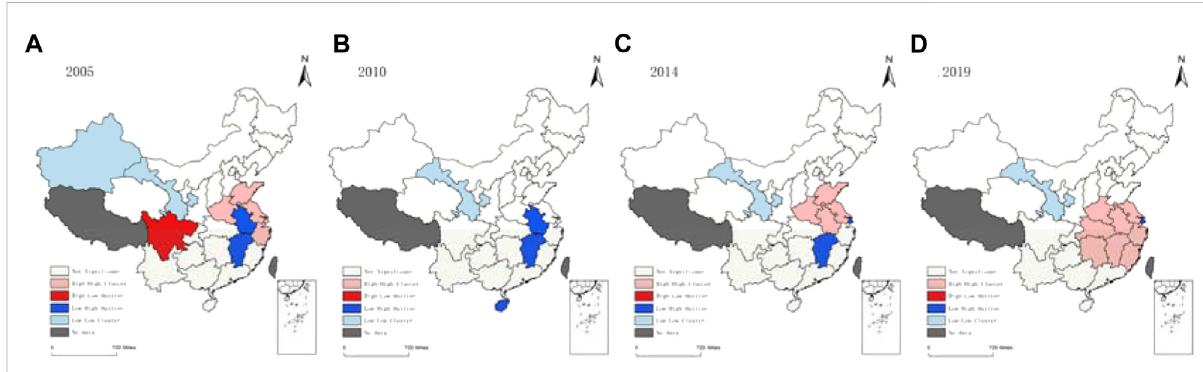
FIGURE 4 Local indicators of spatial association of the coupling coordination. (A) 2005, (B) 2010, (C) 2014, (D) 2019.